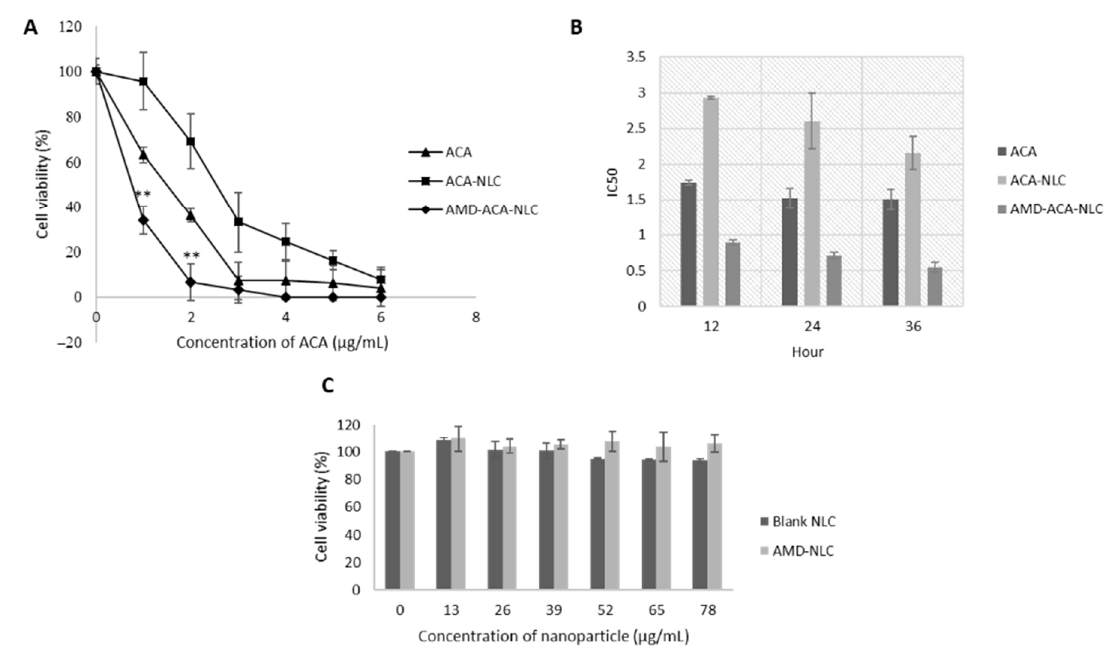
Figure 5. In vitro cytotoxic effects of treatments on PC-3 cell lines. ( A ) Dose-dependent cytotoxicity of ACA, ACA-NLC, and AMD-ACA-NLC on cells after 24 h of incubation. Statistically significant differences between ACA and AMD-ACA- NLC are marked with (** p < 0.01). ( B ) Time-dependent IC 50 of treatments on cells after 12, 24, and 36 h of incubation. ( C ) Dose-dependent cytotoxicity of blank NLC and AMD-NLC on cells after 24 h of incubation. All data are shown as mean ± S.D. of three independent replicates.